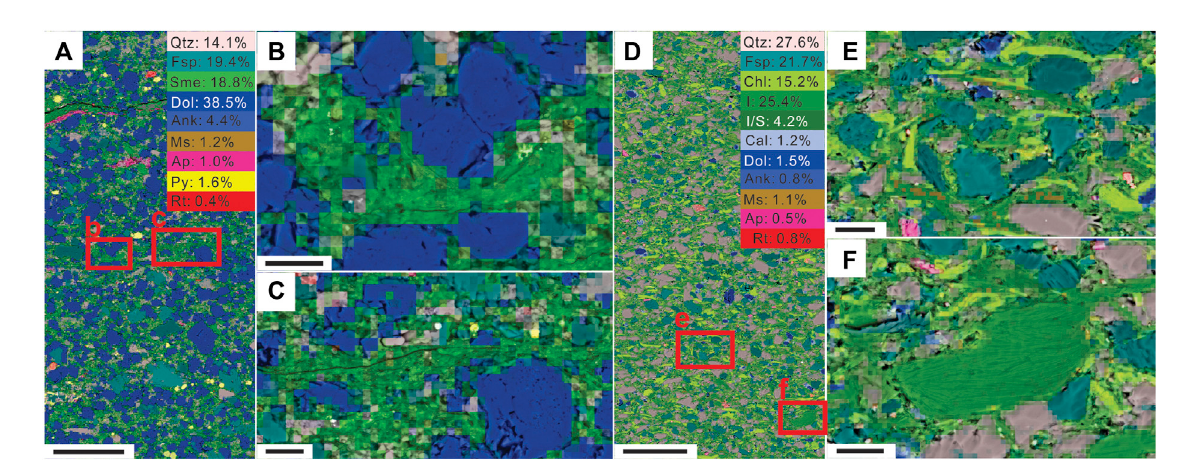
FIGURE 2 Representative mineral maps of theDoushantuo Formation (A – C) and Brachina Gorge (D – F) samples, overlaid on BSE images. Scale bars in (A) and (D) represent 100 μ m; scale bars on zoomed in regions of interest (B,C,E,F) represent 10 μ m. See Figure 1 for mineral legend details. Samples from the Doushantuo Formation are more calcareous and contain fi ner clay minerals, while the Enorama Shale is more siliceous and contains larger clay and mica fl akes with discrete grain boundaries and